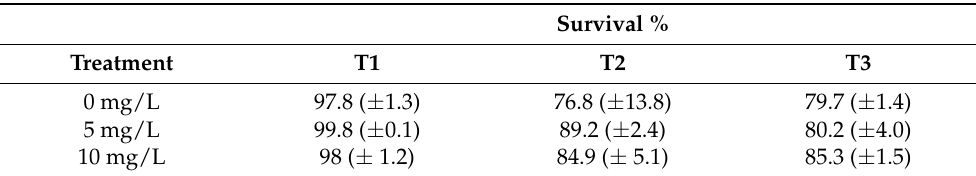
Table 2. Survival rates of each treatment. Larger standard deviation in the T2 0 mg/L samples are due to swim bladder infections in 1 tank. This T2 control tank was impacted two days before sampling so growth depensation effects were